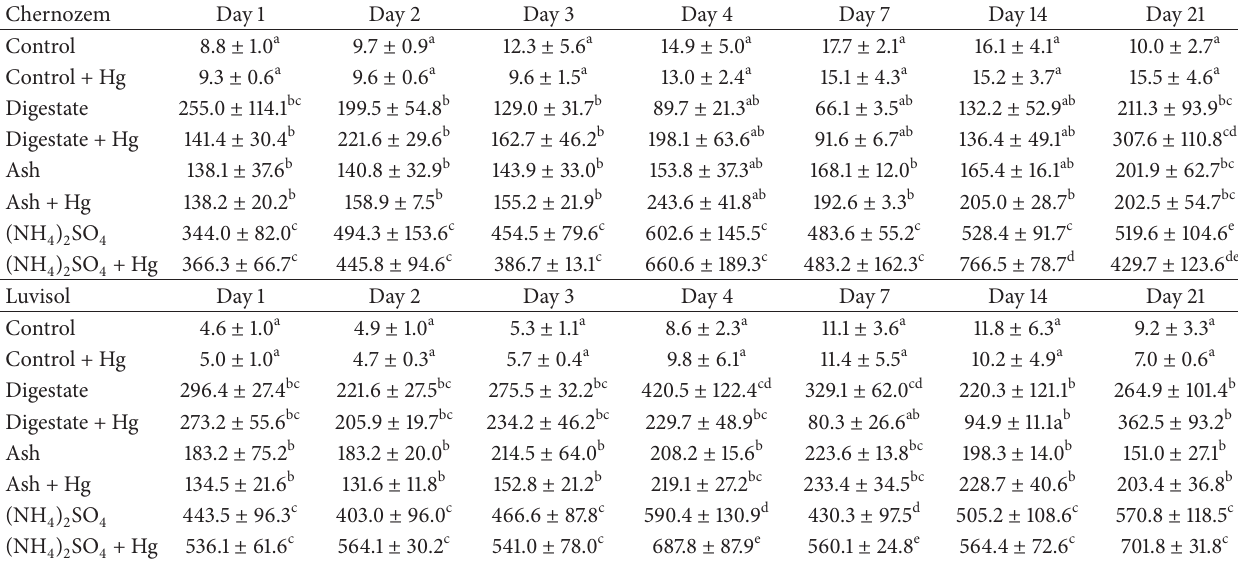
Table 10: The concentrations of S extractable with 0.11molL − 1 acetic acid within the incubation experiment (mg ⋅ kg − 1 ); the averages marked by the same letter did not significantly differ at 𝑃 < 0.05 within individual columns; data are presented as mean ± standard deviation ( 𝑛 = 3